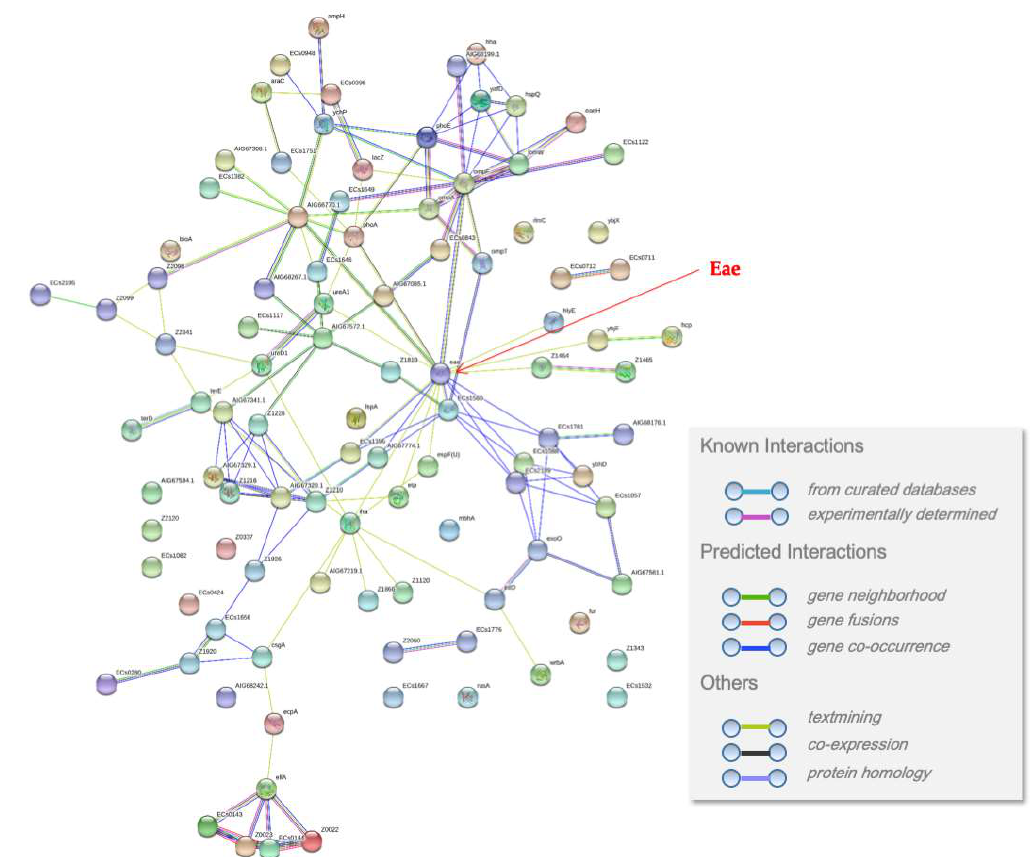
Figure 4. The PPI network of the predicted outer-membrane-embedded protein Eae. Eae is indicated with a red arrow. The PPI information was retrieved from the String database (version 11.0)